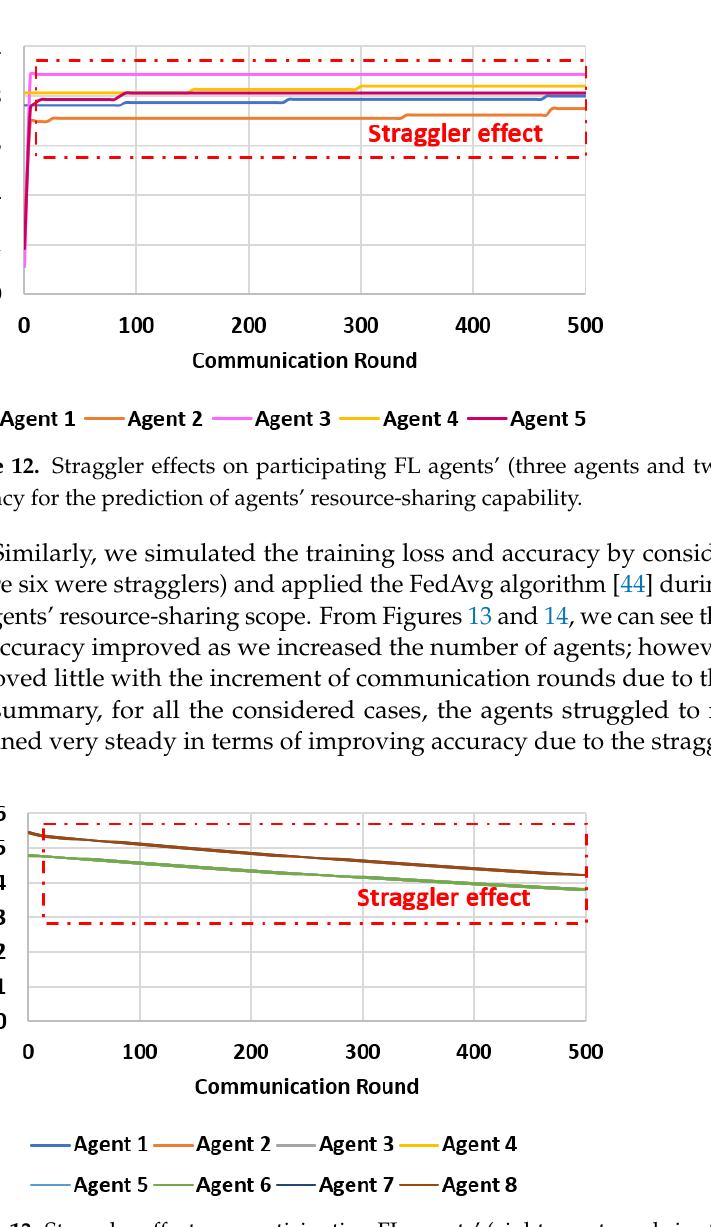
Figure 13. Straggler effects on participating FL agents’ (eight agents and six stragglers) model loss for the prediction of agents’ resource-sharing